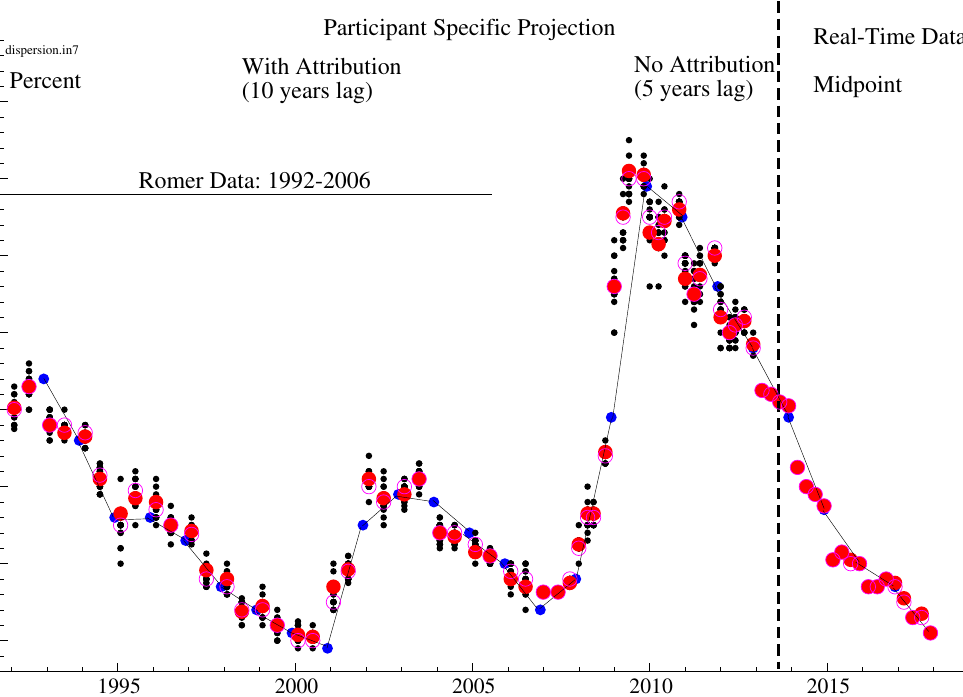
Figure 2. Current-Year Projections for Unemployment.